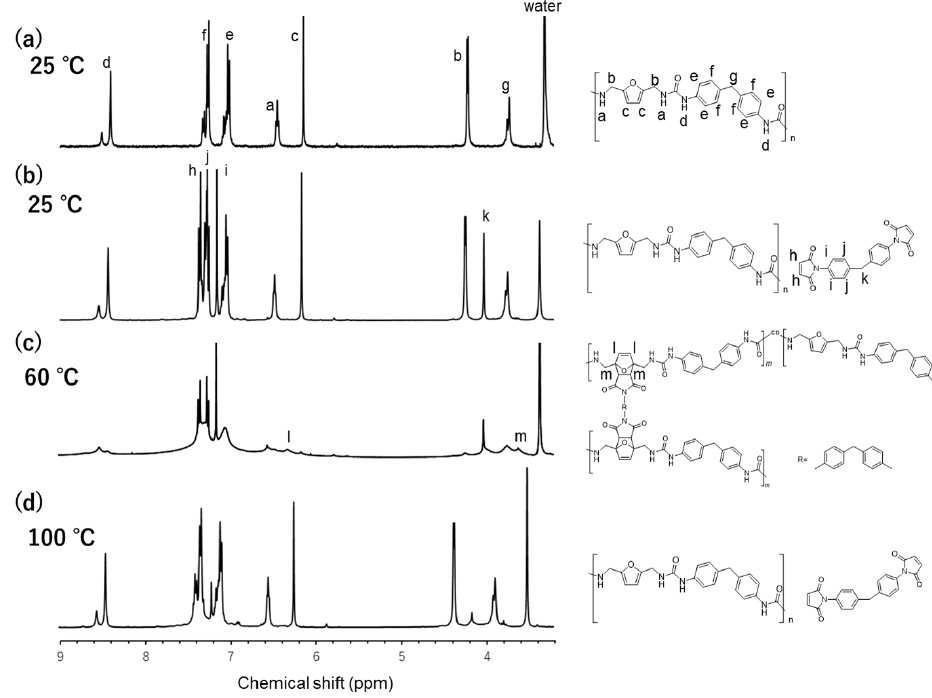
Figure 2. 1 H NMR (400 MHz, DMSO- d 6 ) spectra of ( a ) PU-1 taken at 25 °C, ( b ) PU-1 mixed with BMI at 25 °C, ( c ) PU-1 mixed with BMI at 60 °C, and ( d ) PU-1 mixed with BMI at 100 °C. Protons in structures (right) marked as a-m were individually assigned to NMR signals.